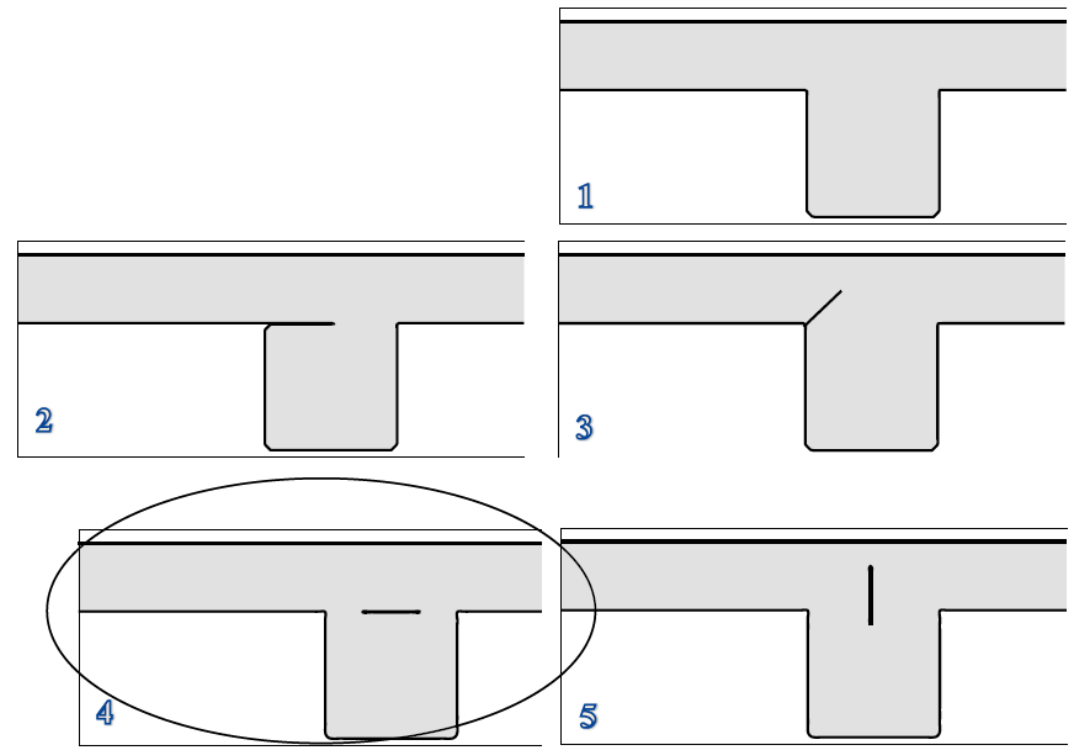
Figure 2. Different cases of free communication between the main channel and the lateral basin [from [2]).